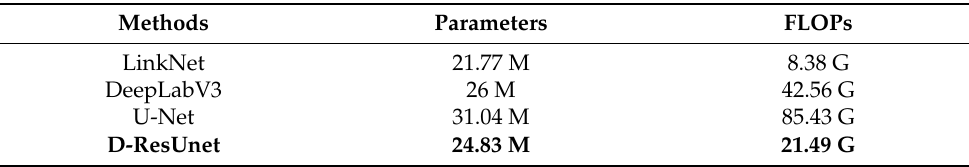
Table 8. Calculation complexity of four